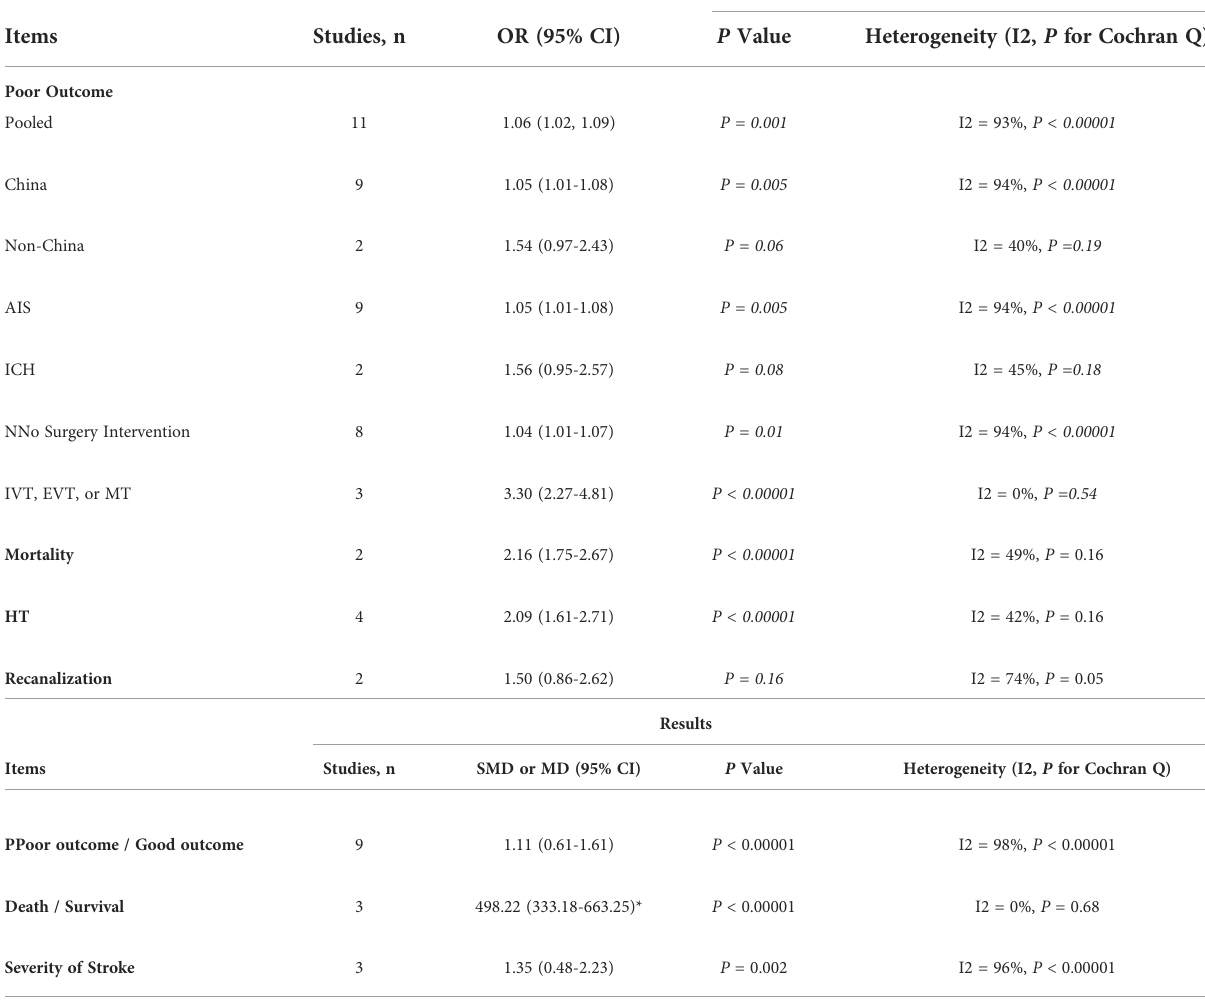
TABLE 2 Meta-Analysis and subgroup analysis of Different Outcomes.